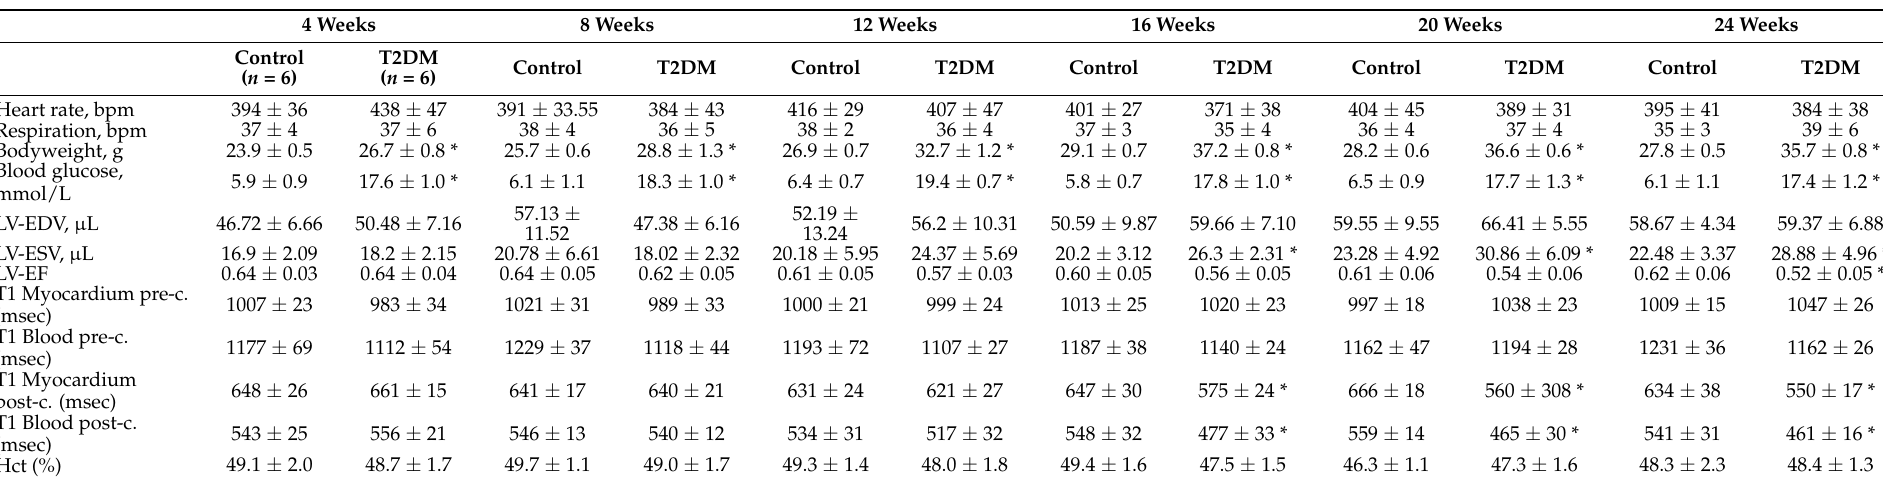
Table 1. Animal characteristics of both study and control group mice during the 24-week